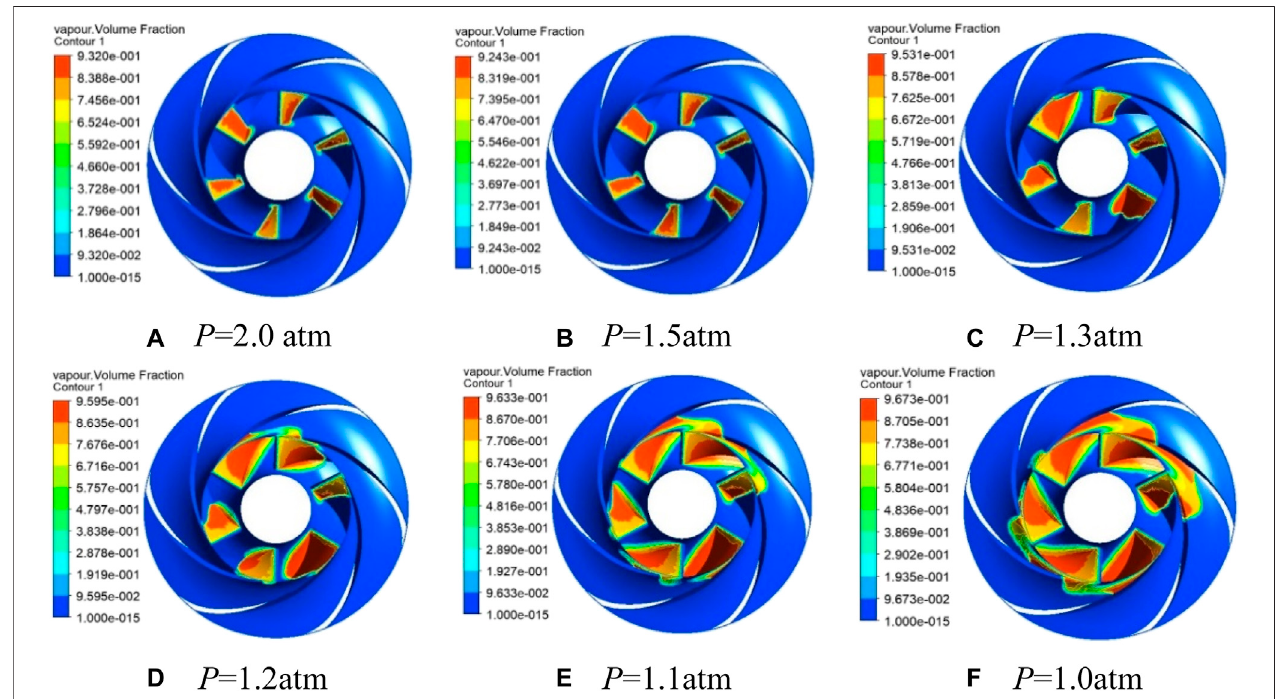
FIGURE 9 | Volume distribution of cavitation with the trash rack. P in represents different atmospheric pressures.